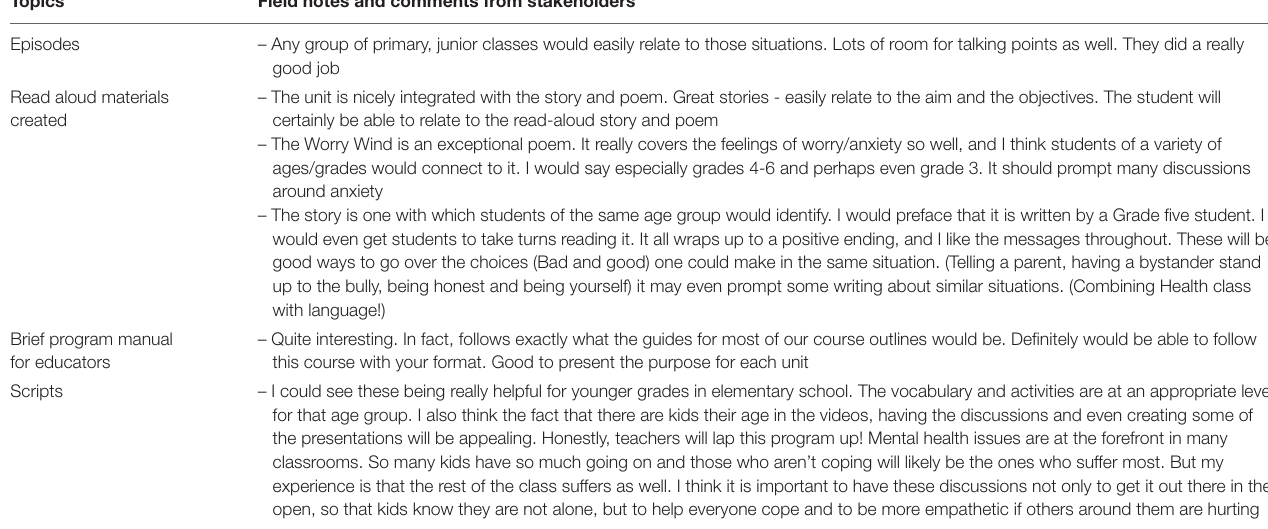
TABLE 7 | Retired teachers and mental health professionals qualitative data. Topics Field notes and comments from